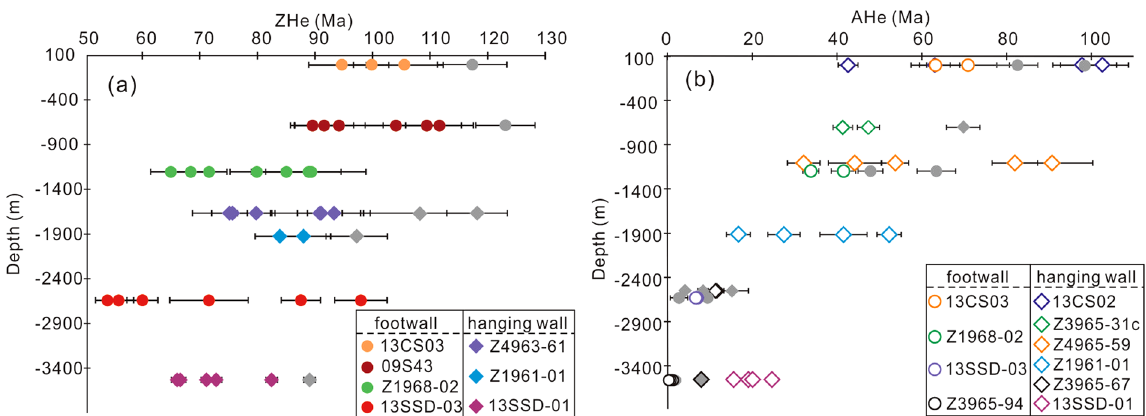
Figure 3. Plots of depths versus ZHe ( d ) and AHe ( e ) ages for the Sanshandao Au deposit. Note that the data in grey are outliers detected by Chauvenet’s